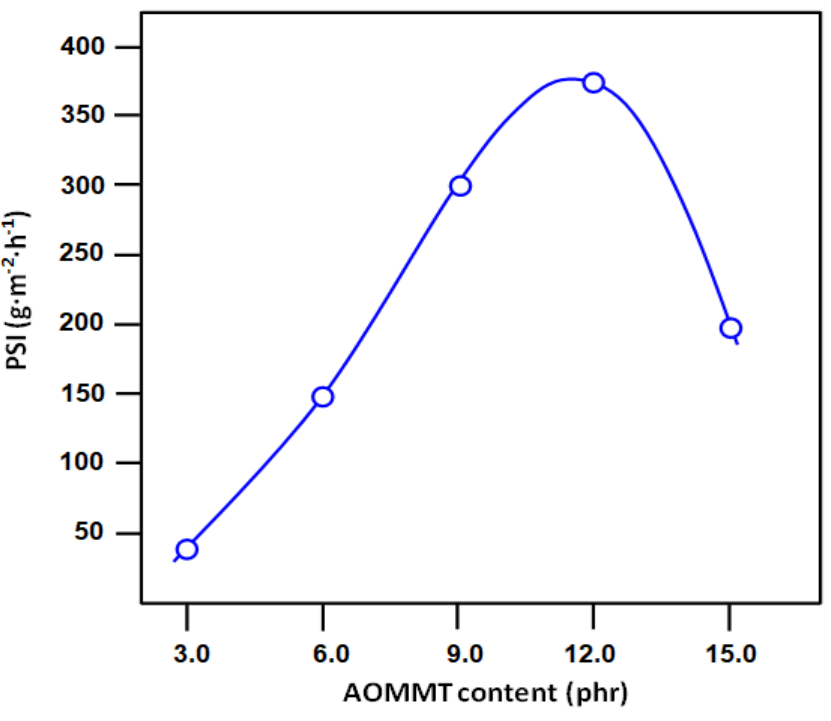
Figure 12. Variation in PSI versus the OMMT content in the OMMT/CSBR membrane for the separation of the azeotropic toluene/methanol mixture. Table 7. PV performance of CSBR/OMMT nanocomposite Table 8. Comparative results of the methanol/toluene mixture separation by pervaporation using different rubbery membranes taken from the literature